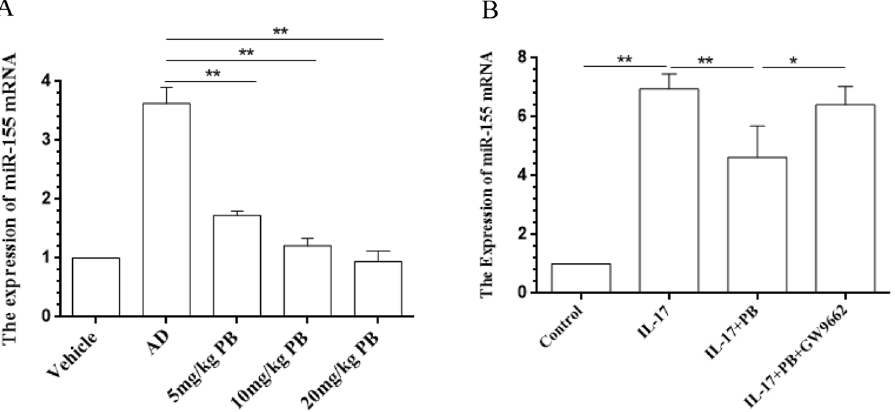
Figure 9. Regulation of PB on miR-155 expression. ( A ) Total RNA from the lesional skin tissues of NC/Nga mice was extracted and the expression of miR-155 was performed by qRT-PCR. The relative expression of miR- 155 was normalized to the endogenous control U6. Data are representative of two independent experiments and presented as mean ± SD of n = 8 mice per group. Vehicle, intact mice with saline treatment; AD, DNFB- sensitized and challenged mice; PB, pseudolaric acid B. ( B ) RAW264.7 cells were pre-incubated with GW9662 (1.0 μ mol/l) for 1 h before added with PB (0.5 μ mol/l). After 21 h, cultured cells were stimulated with IL-17 (10 ng/ml) for 3 h. Cells were harvested and total RNA was used to quantify the level of miR-155 mRNA by qRT- PCR. Data are presented as mean ± SD. Each measurement was performed in duplicate and all experiments were repeated three times. * P < 0.05, ** P <